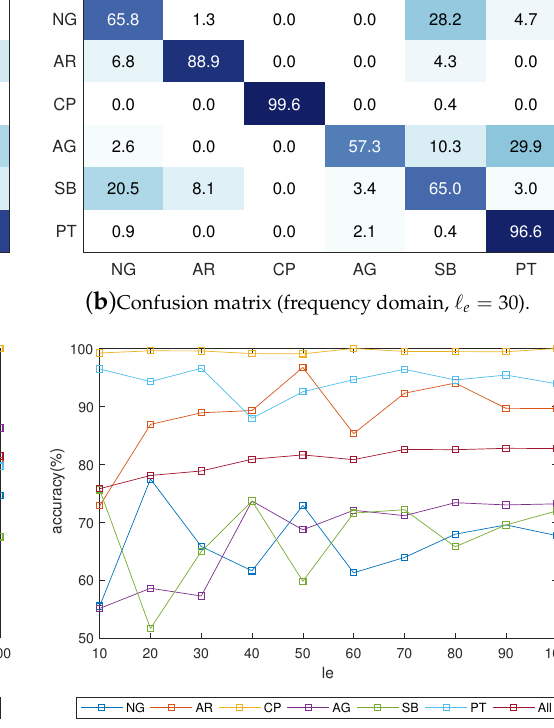
( d ) Variations of classification accuracies over (cid:96) e (frequency domain). Figure 8. Classification performance of t-LapSVM under LS1 ( k 1 = 6, γ K = 10 − 6 , γ M = 1, t 1 = 0.35). Table 1. Classification performances under different parameters of t-LapSVM (time domain, (cid:96) e = 30). Parameters of t-LapSVM NG AR CP AG SB